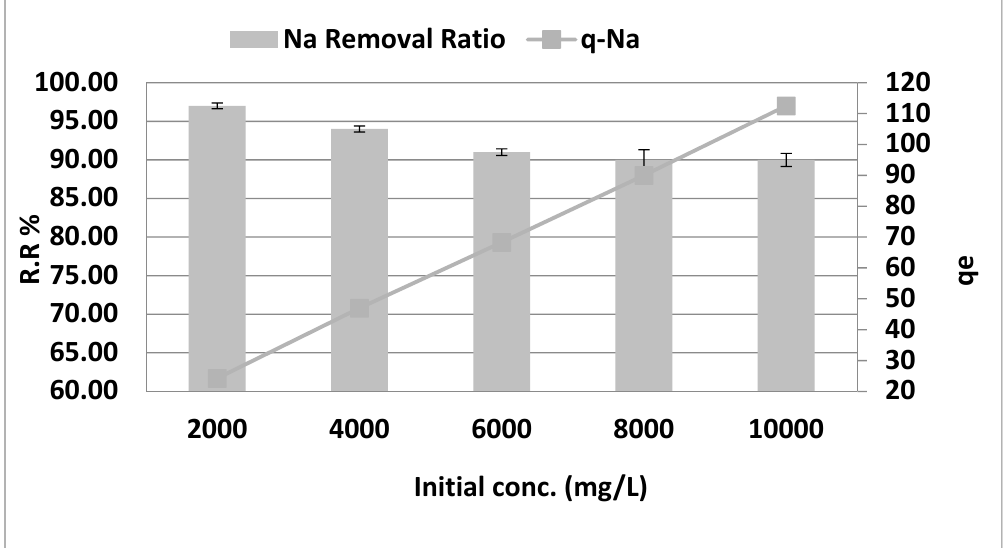
Figure 9. Effect of initial conc. of NaCl on the removal efficiency and the adsorption capacity of NaCl at adsorbent dose = 8 g·L − 1 , pH = 4, time = 150 min, and agitation speed = 300 rpm at 27 °C.